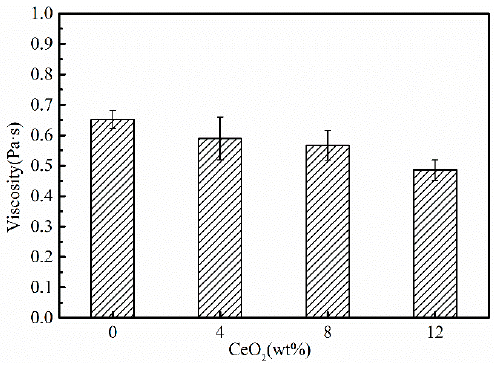
Figure 6. The viscosity of experimental mold fluxes at 1300 °C with different CeO 2 contents.